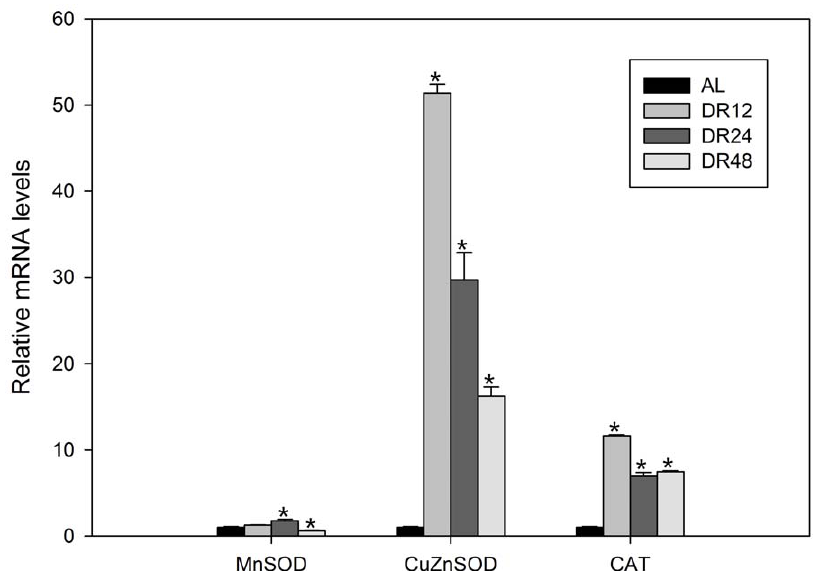
Figure 7. Relative mRNA expression levels of MnSOD, CuZnSOD and CAT from B.calyciflorus under various DR conditions. AL, DR12, DR24 and DR48 represent rotifer groups starved for 0, 12, 24 and 48 h, respectively. Bars represent standard errors. The expression levels were statistically analyzed by one-way ANOVA with the Tukey test. ( * P , 0.05).